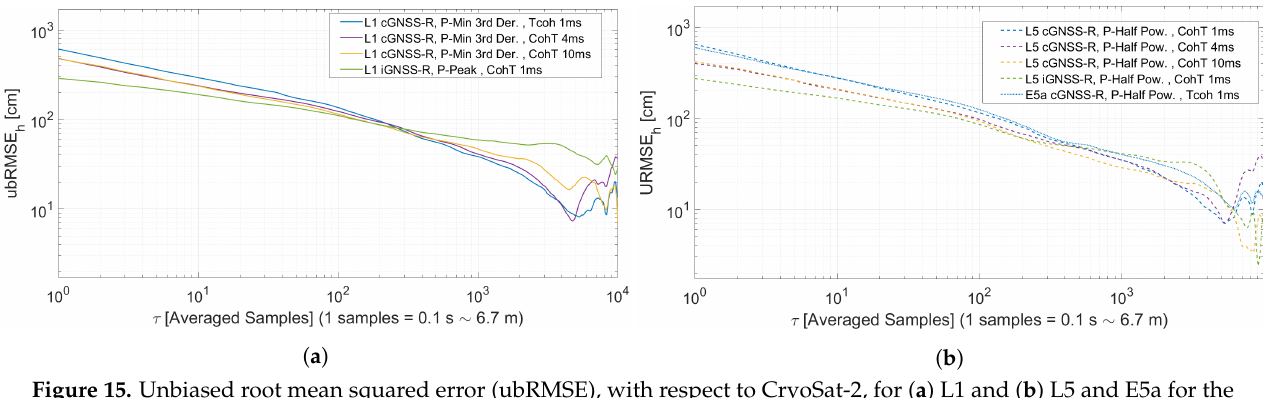
Figure 15. Unbiased root mean squared error (ubRMSE), with respect to CryoSat-2, for ( a ) L1 and ( b ) L5 and E5a for the computed altimetric methods and coherent integration